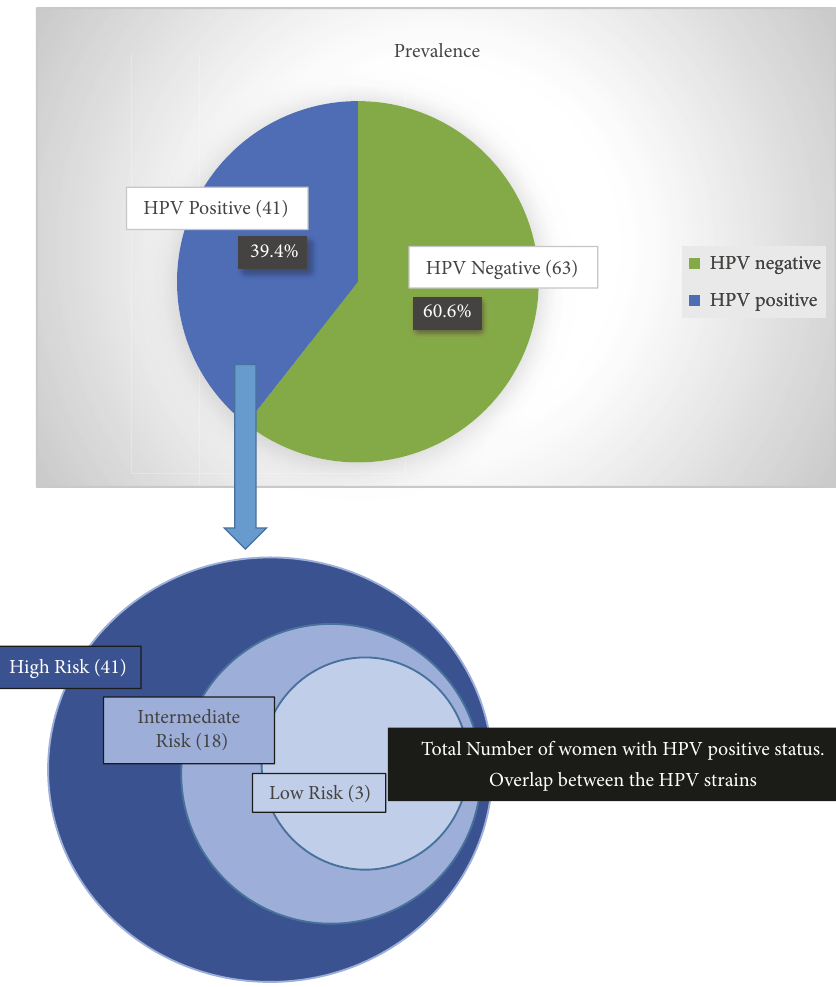
Figure 1: Prevalence of HPV infection in the study population and distribution of high, intermediate, and low risk HPV virus in the samples.